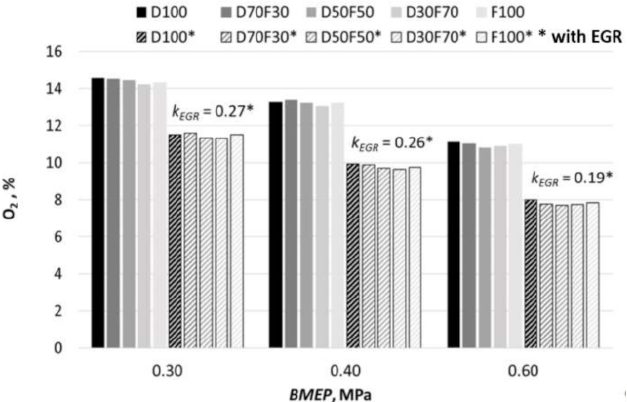
Figure 15. Dependence of the O 2 concentration on fuel composition and the engine